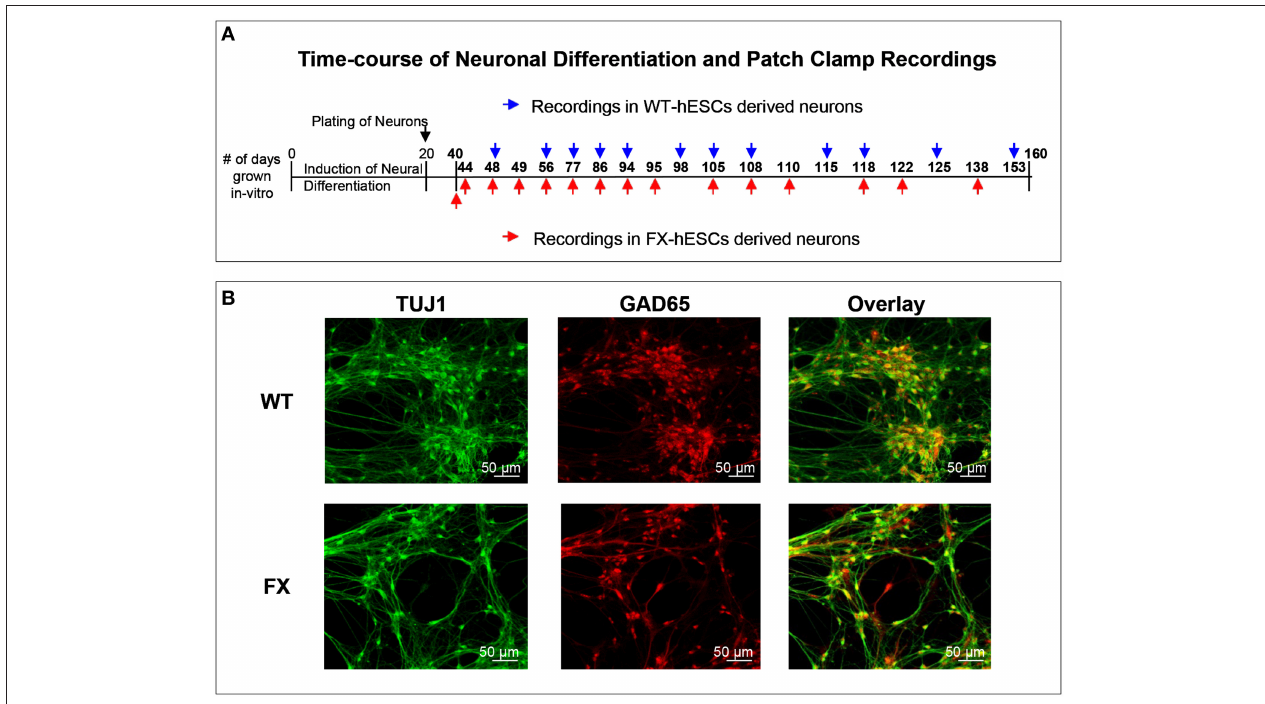
FIGURE 1 | (A) Outline of the time-course of neuronal differentiation and the time-points at which electrophysiological recordings were carried out in WT (blue) and FX (red) human embryonic stem cells-derived neurons. (B) Immunofluorescence images for cellular localization of TUJ1 (green, left), GAD65 (red, middle) and their overlay (yellow, right); in WT (top row), and FX (bottom row) 40-days old neurons. Scale is 50 µ m.